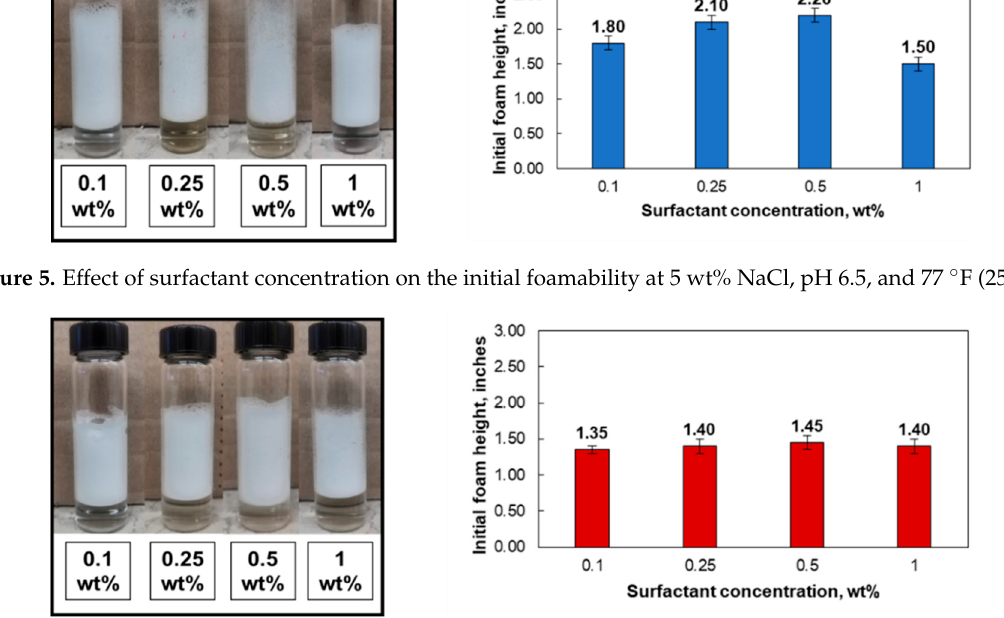
Figure 6. Effect of surfactant concentration on the initial foamability at 20 wt% NaCl, pH 6.5, and 77 ◦ F (25 ◦ C).